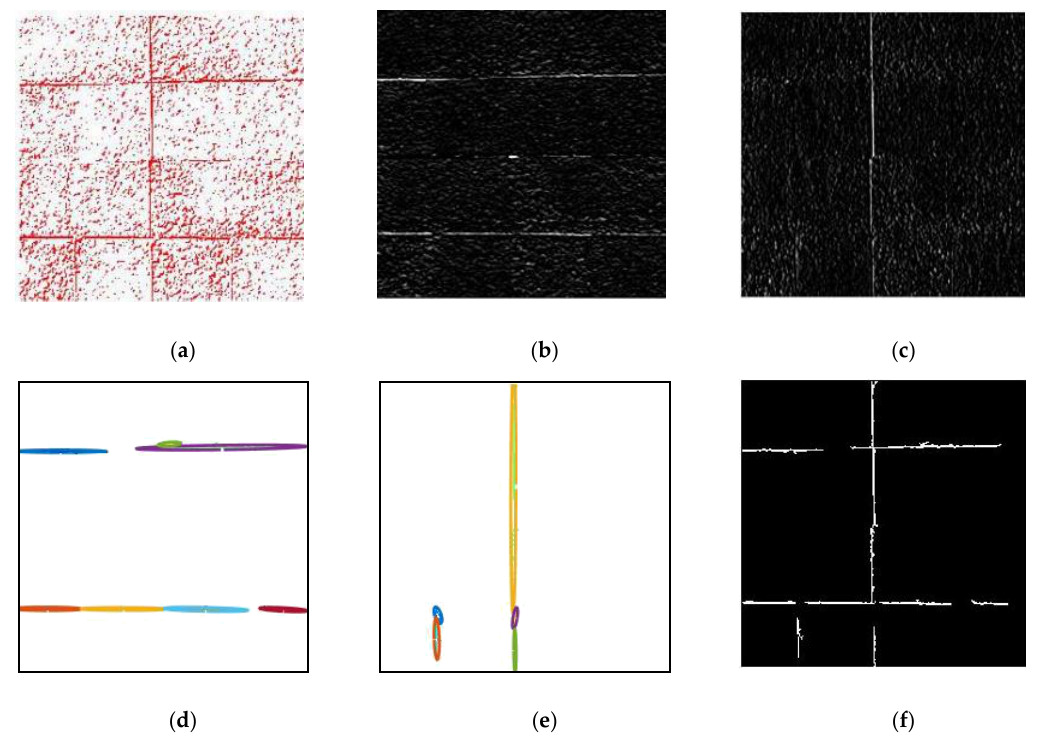
Figure 17. Evaluation of algorithm on surface images of earthen heritage. ( a ) Image 4, ( b ) horizontal edge map, ( c ) vertical edge map, ( d ) horizontal CCs (area > 30 pixels), ( e ) vertical CCs (area > 30 pixels) and ( f ) architectural feature map.